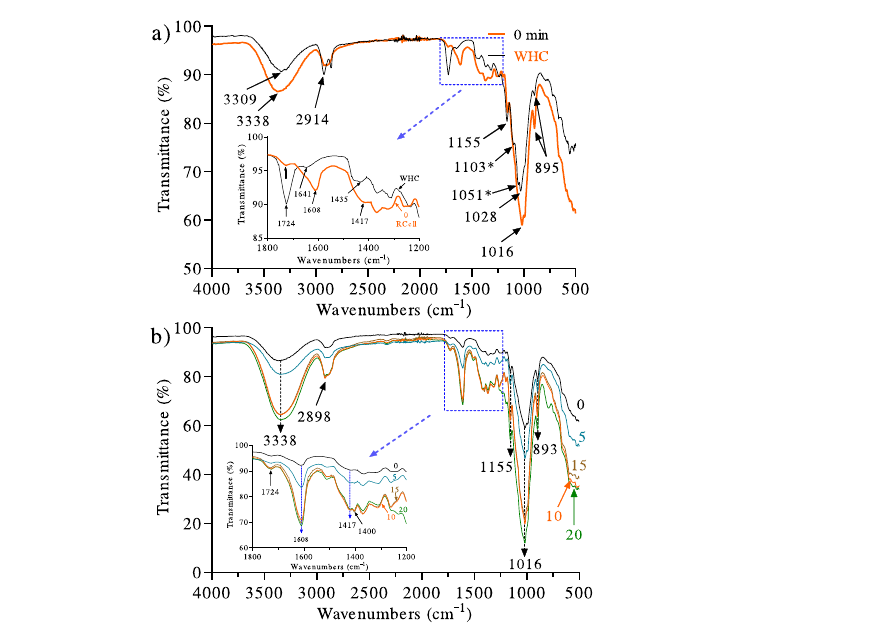
Figure 1. Infrared spectra of ( a ) cellulose fiber extracted from the wheat husk (WHC) and regenerated cellulose (0 min), without exposure to UV radiation, from solution in the DMAc/LiCl solvent system and ( b ) exposure time effect of UV radiation (0, 5, 10, 15, and 20 min) on regenerated cellulose from solution in the DMAc/LiCl solvent system. * Only present in 0